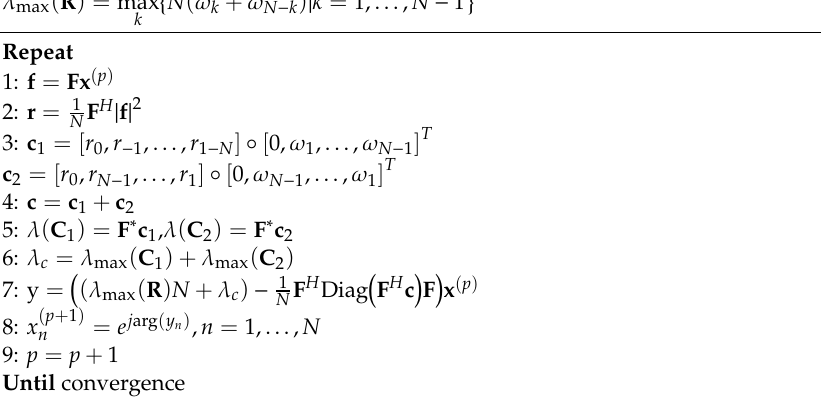
Table 1. Majorization–minimization (MM) procedures of the periodic Weighted Integrated Sidelobe Level (PeWISL)